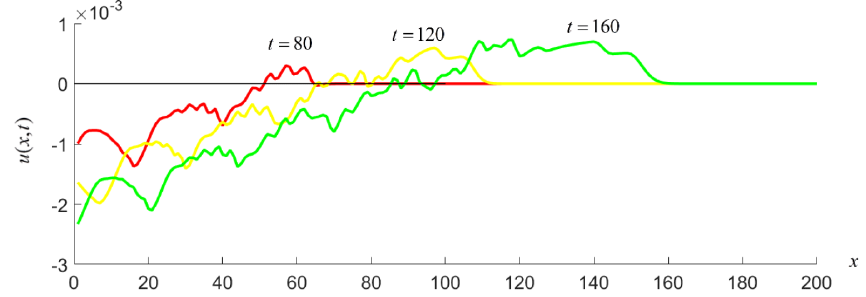
Figure 6. Displacement u(x,t) at different time moments versus the horizontal coordinate x for the tension–compression harmonic impulse.